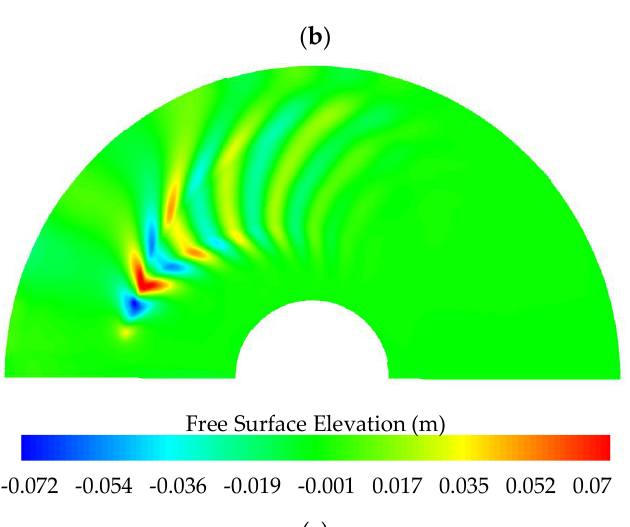
Figure 8. Development of wakes at the free surface at Fr = 0.5. ( a ) t = 5 s, ( b ) t = 10 s, ( c ) t = 15 s. The free-surface waves generated by SUBOFF at different velocities of the center of buoyancy are shown in Figure 9. It is obvious that the higher the velocity reached is, the more significant the wave is, with a longer wavelength obtained in the transverse